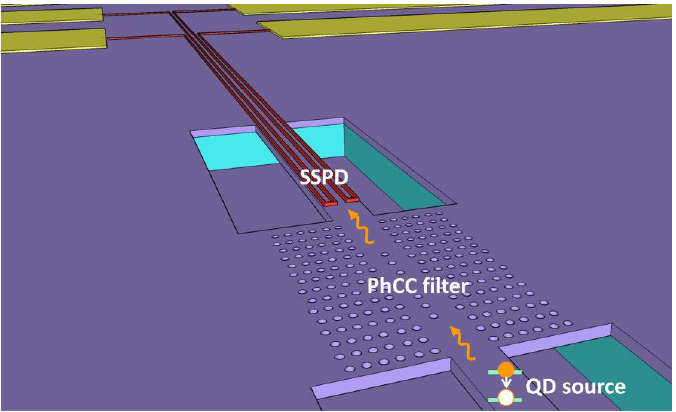
Figure 1. Sketch of the proposed approach for the quantum photonic integrated circuits (QPIC). Single photons are produced via spontaneous emission of excitons in quantum dots (QDs), efficiently funneled in waveguides, filtered by a photonic crystal cavity (PhCC) and detected by waveguide superconducting single photon detectors (SSPDs).